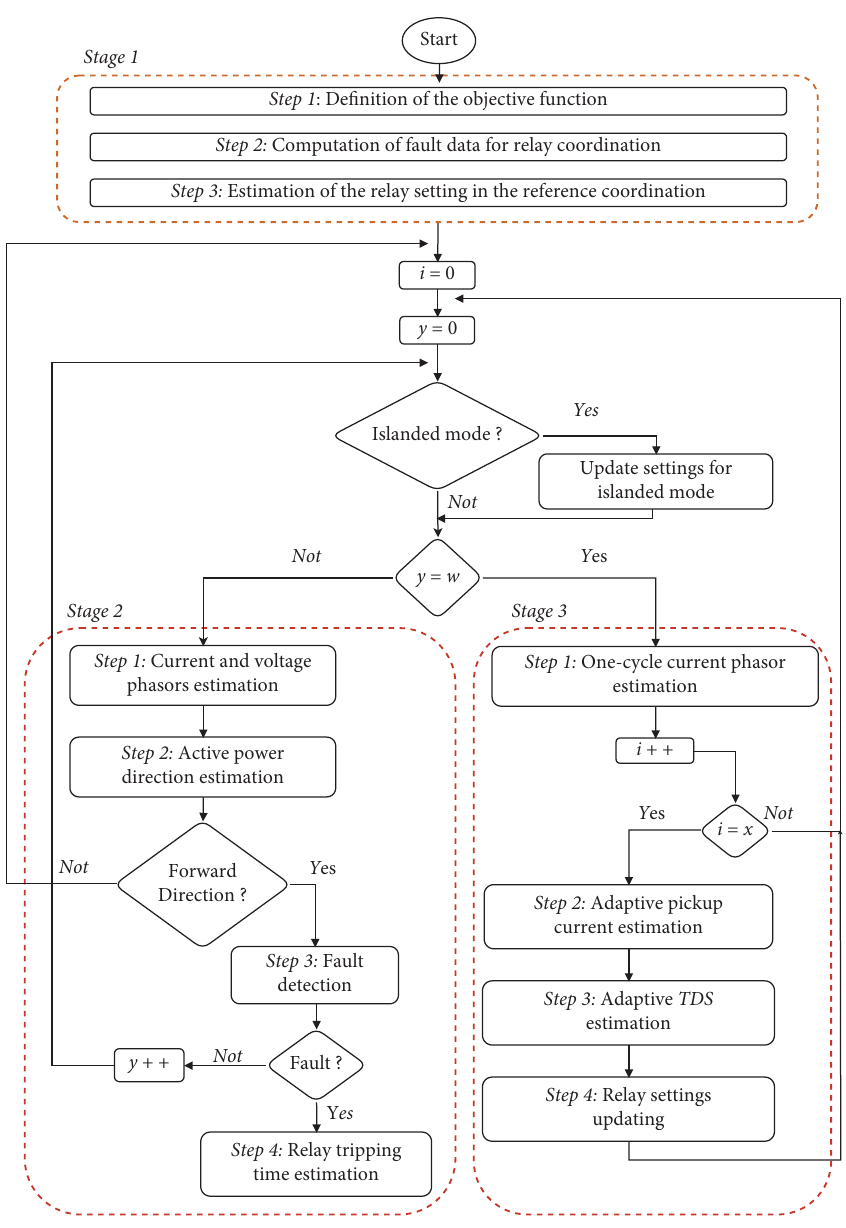
Figure 2: Proposed communicationless adaptive protection